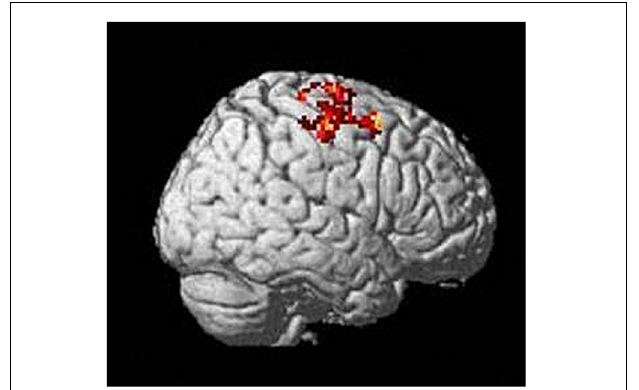
FIGURE 4 | Higher activation in motor cortex (righthemispheric BA 4 and 6) in the tiapride group during task performance compared to tapping (two-sample t -test tiapride > placebo, p < 0 . 05 FWE